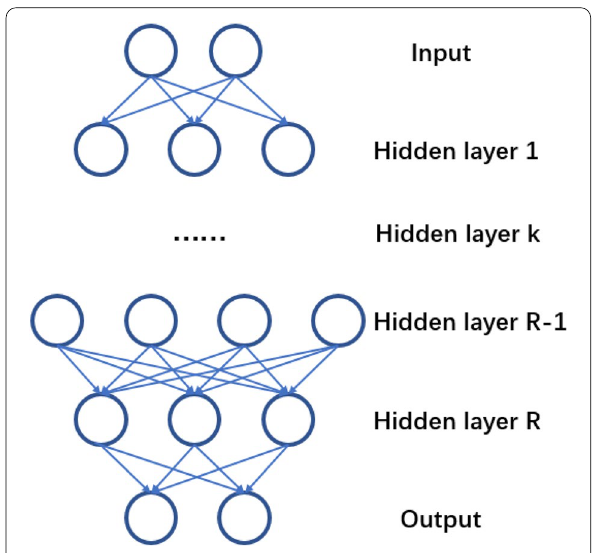
Figure 3 Structure of the neural